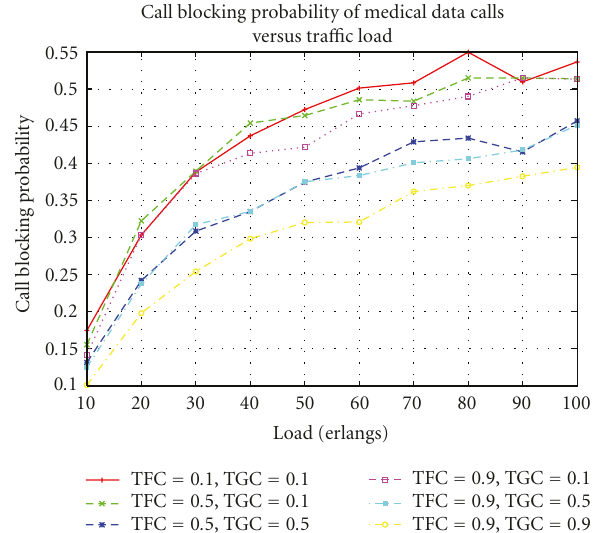
Figure 5: Call blocking probability of medical calls versus tra ffi c